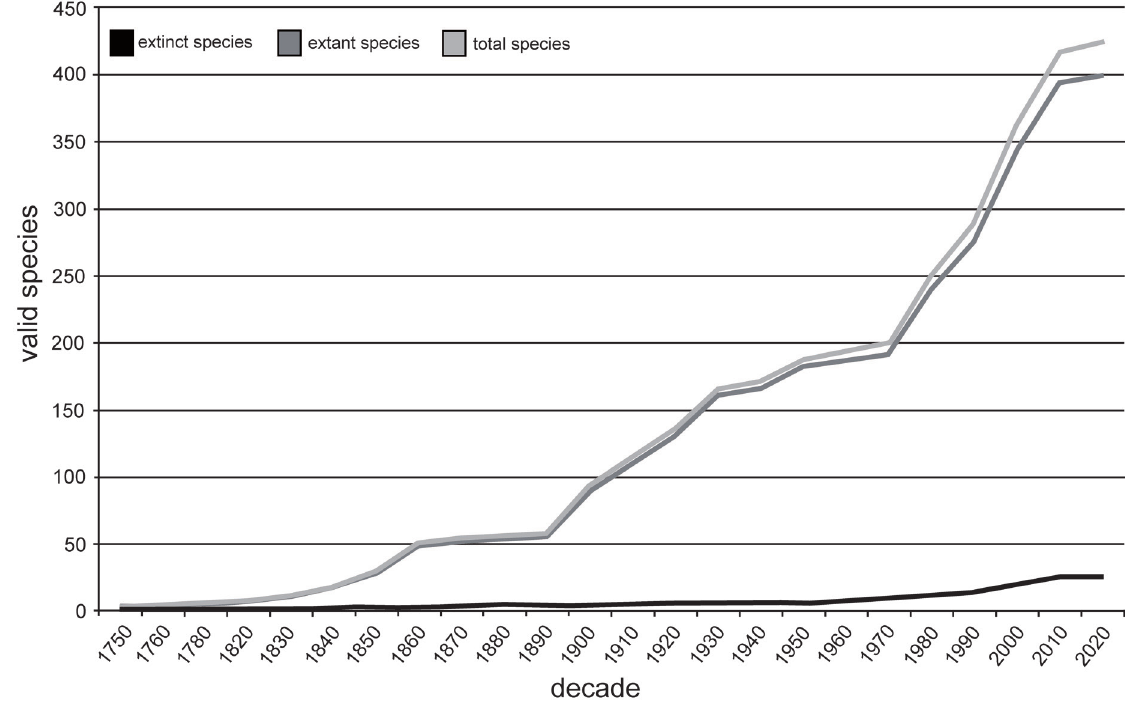
Fig. 3. Taxonomic description curve for valid extant, extinct, and total species of world Megaloptera by decade (based on data in Fig.